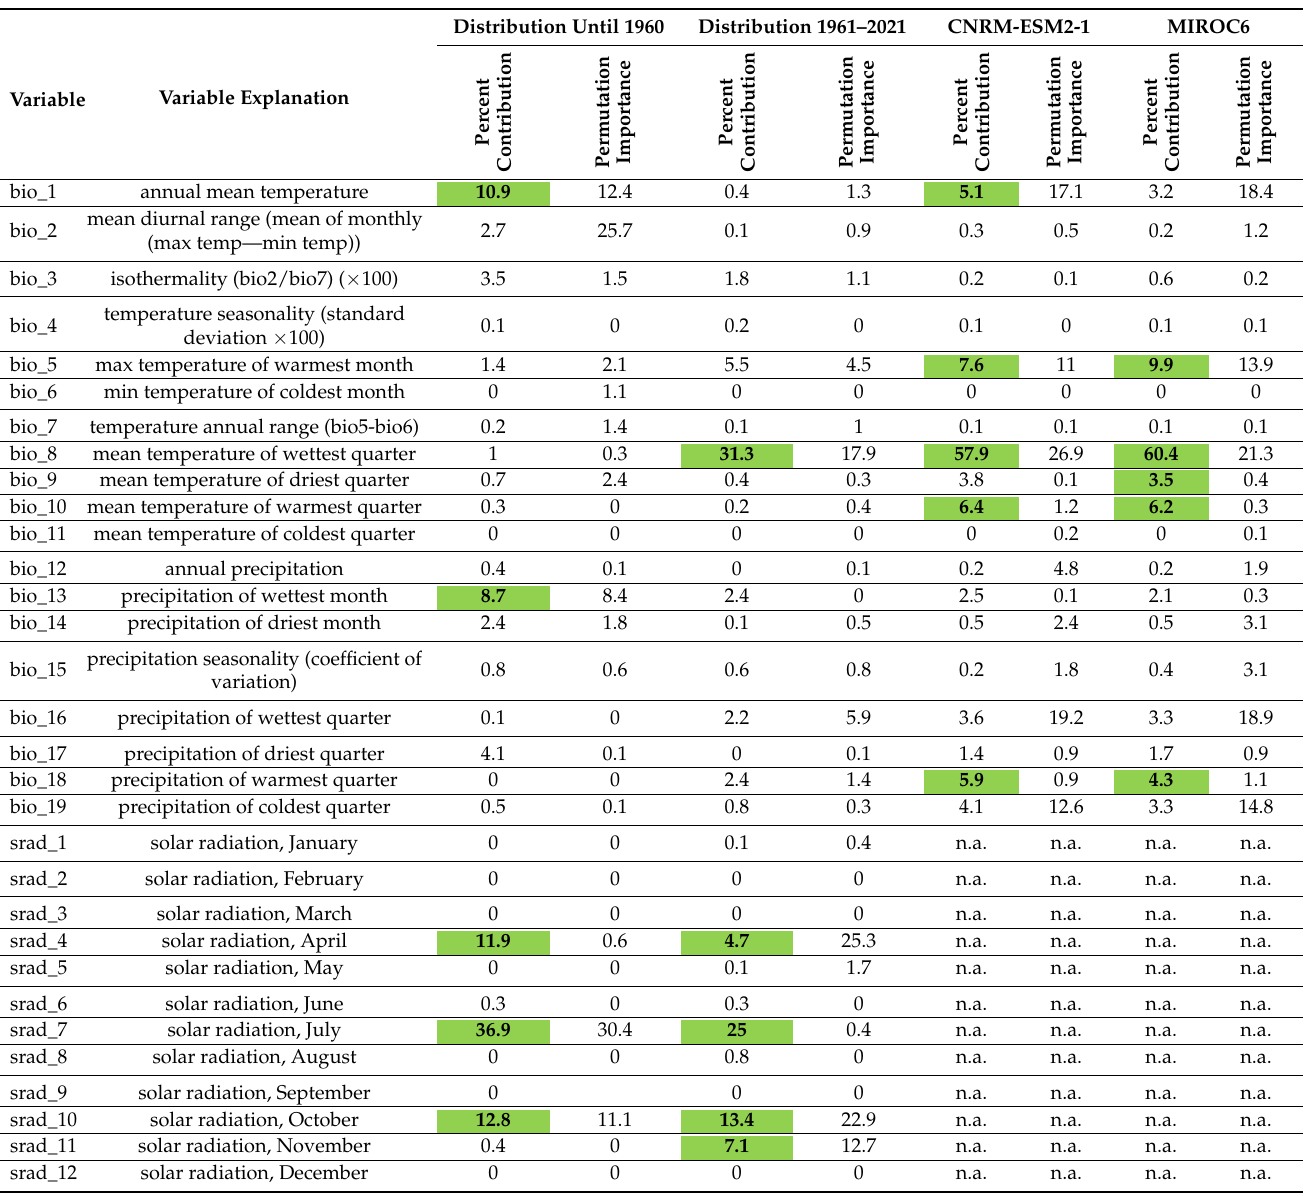
Table 1. Predictive contributions for two periods (until 1960 and 1961–2021) and for two climatic models for